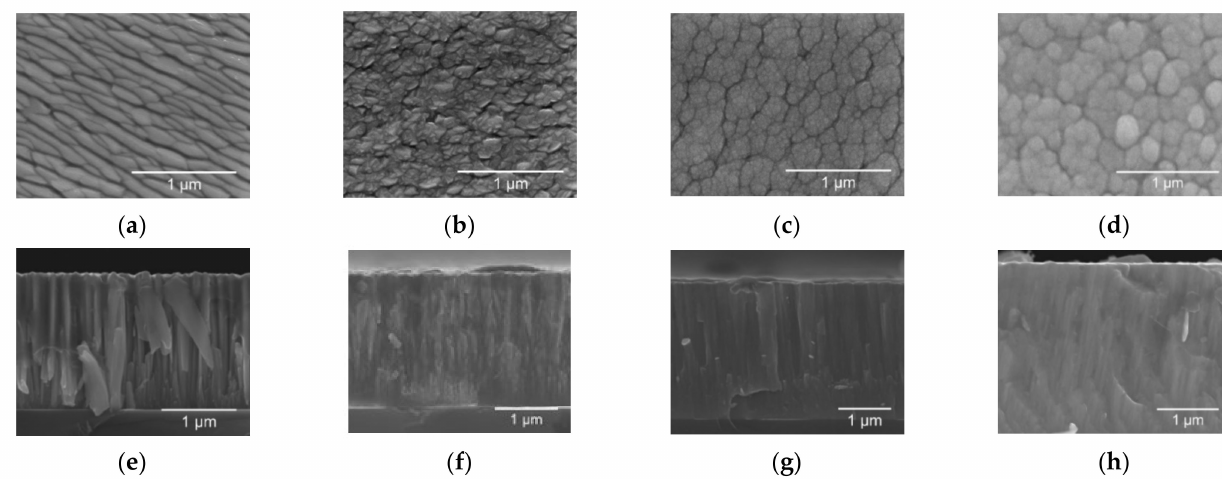
Figure 5. Surface SEM images of the first series of MoO x films deposited on a silicon substrate with ( a ) 0 O 2 /Ar-60 min; ( b ) 0.16 O 2 /Ar-60 min; ( c ) 0.32 O 2 /Ar-60 min; ( d ) 0.48 O 2 /Ar-60 min. Cross-section SEM images of the first series of MoO x films deposited on a silicon substrate with ( e ) 0 O 2 /Ar-60 min; ( f ) 0.16 O 2 /Ar-60 min; ( g ) 0.32 O 2 /Ar-60 min; ( h ) 0.48 O 2 /Ar-60